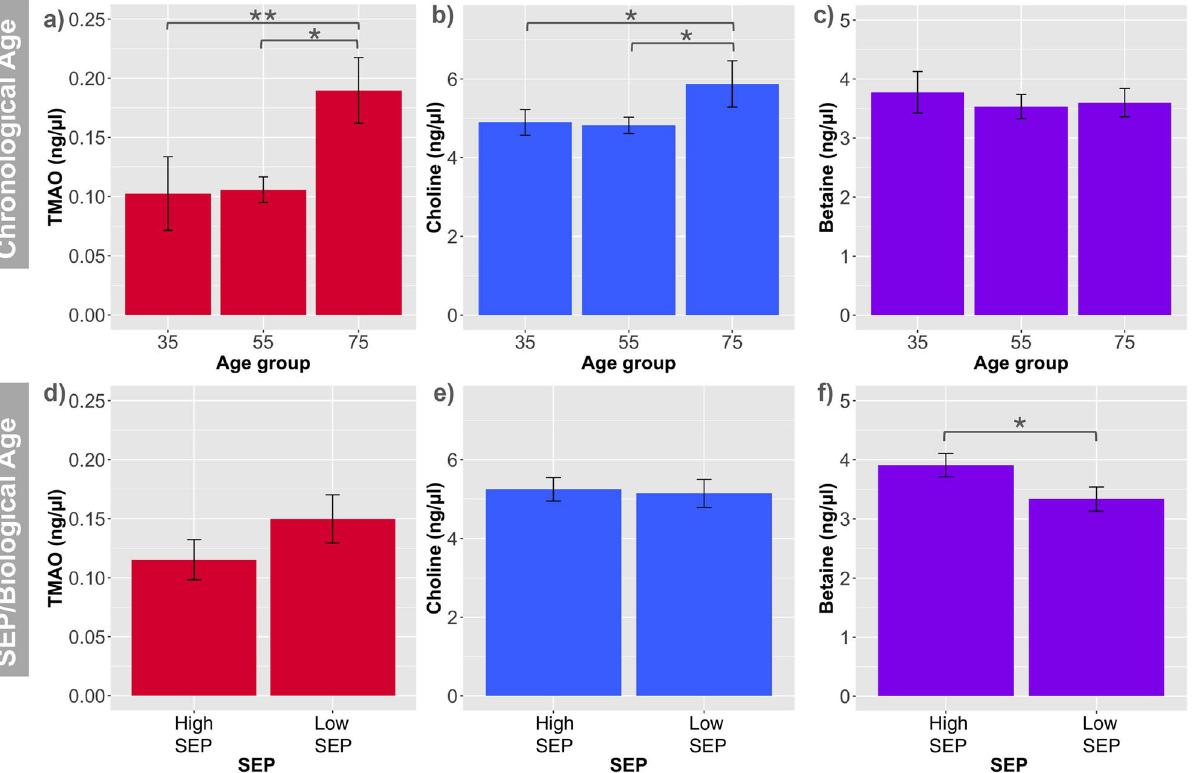
Figure 1. Changes in elements of one carbon metabolism with chronological and biological age/SEP. Variations in mean TMAO, betaine and choline levels across 3 tertiles of chronological age ( a – c ). Variations of TMAO, Betaine and Choline levels across two extremes of biological age and SEP, grouped by those that are the least deprived with the longest telomeres (High SEP) and the most deprived with the shortest telomeres (Low SEP) ( d – f ). Error bars represent standard error of the mean. ANOVA and TukeyHSD tests were performed to generate adjusted p values for multiple comparisons. Where significance occurred between groups, graphs were labeled as follows: p < 0.05 = *, p < 0.01 = **.